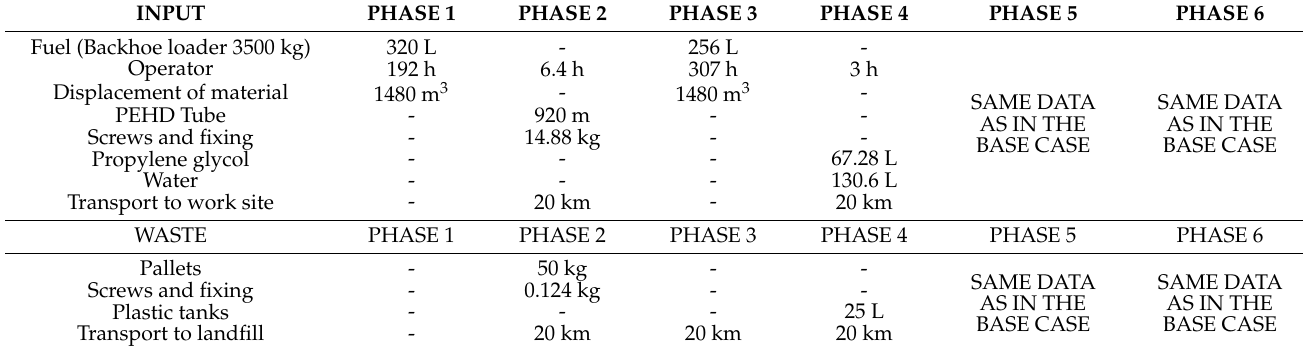
Table 1. Alternative A inventory.